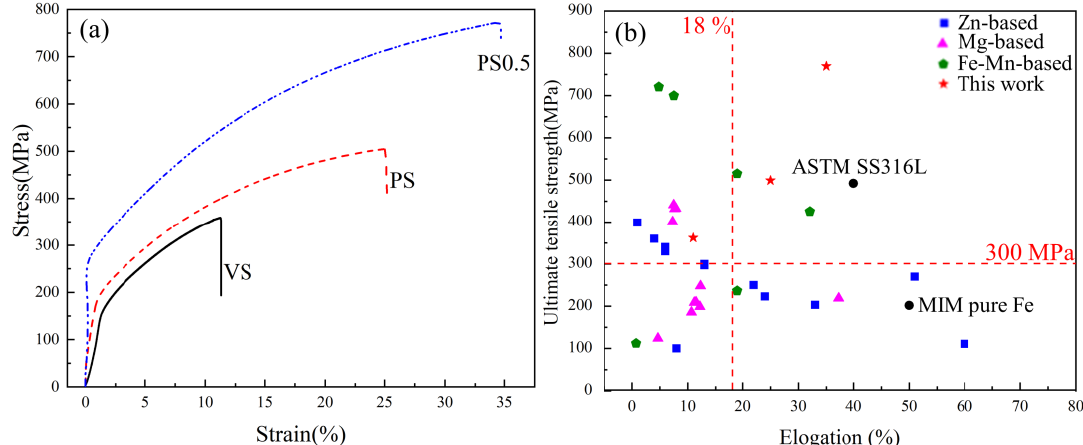
Figure 4. ( a ) The tensile stress – strain curve and ( b ) comparison of the comprehensive mechanical properties with the biodegradable Fe-Mn, Mg, and Zn alloys reported in the main the literature [17 – 24].